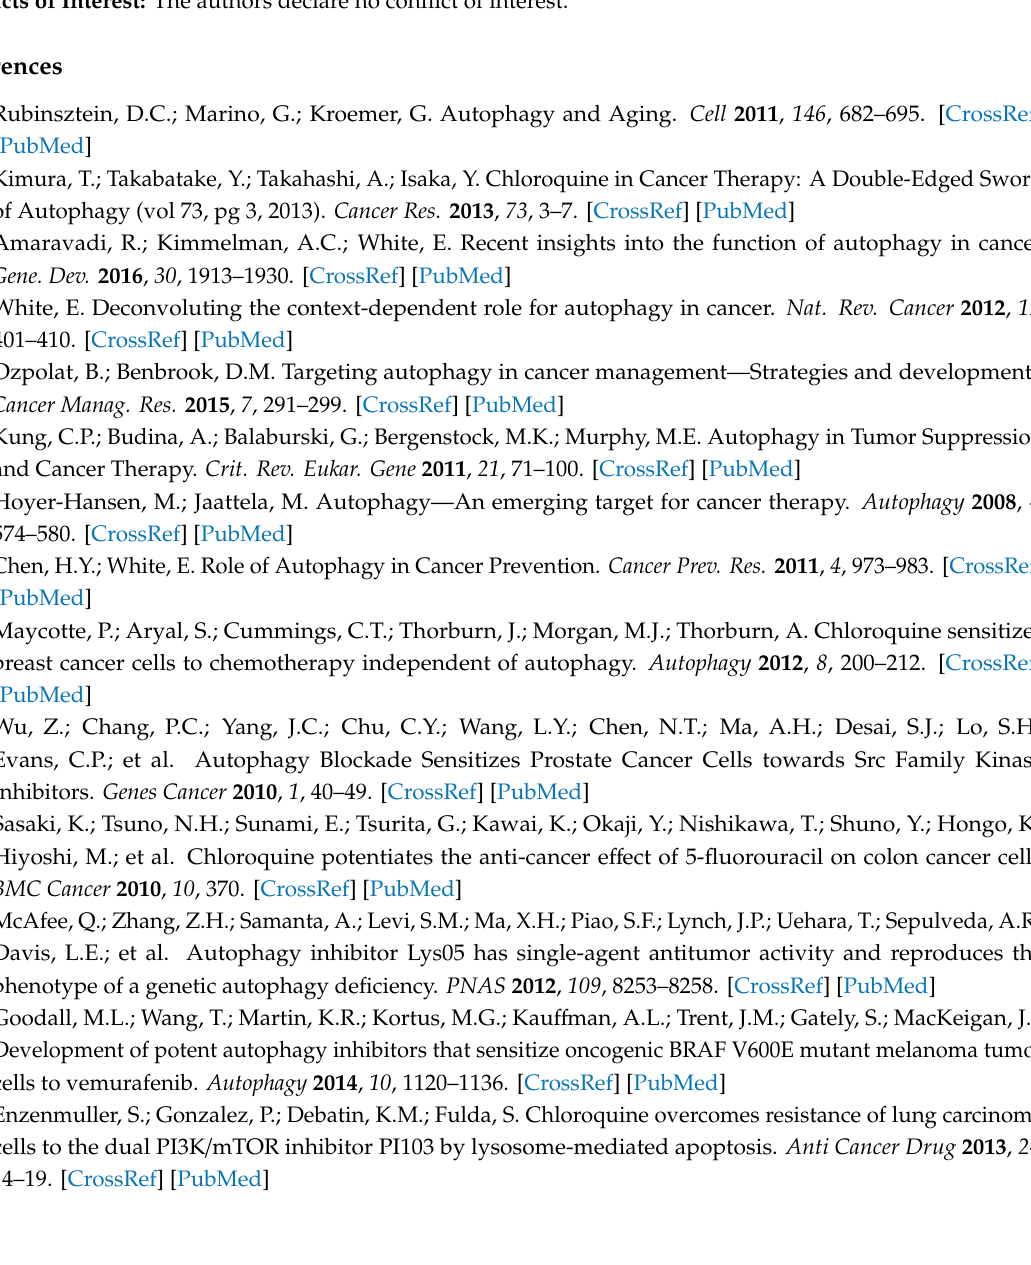
Figure S1: Compounds with a 6-methylpyrimidine-2,4-diamine structure could cause lysosome inhibition, Figure S2: 163N could inhibit autophagy flux, Figure S3: Tumor cells HeLa, HCT116, A549, MGC803, U87, KYSE150, MDA-MB-231, T98G, HL60, and normal cells HL60 and MRC-5 cells were treated with 0–40 µ M of 163N for 48 h, and CCK-8 assay was performed to assess cell viability, Figure S4: The identification of ATG4B knockout HCT116 cells, Figure S5: 163N induces cell death through targeting autophagy, Figure S6: 163N could inhibit tumor growth in vivo without obvious toxicity to organs, Figure S7: The uncropped Western blots and molecular weight markers of the figure 3 in the main